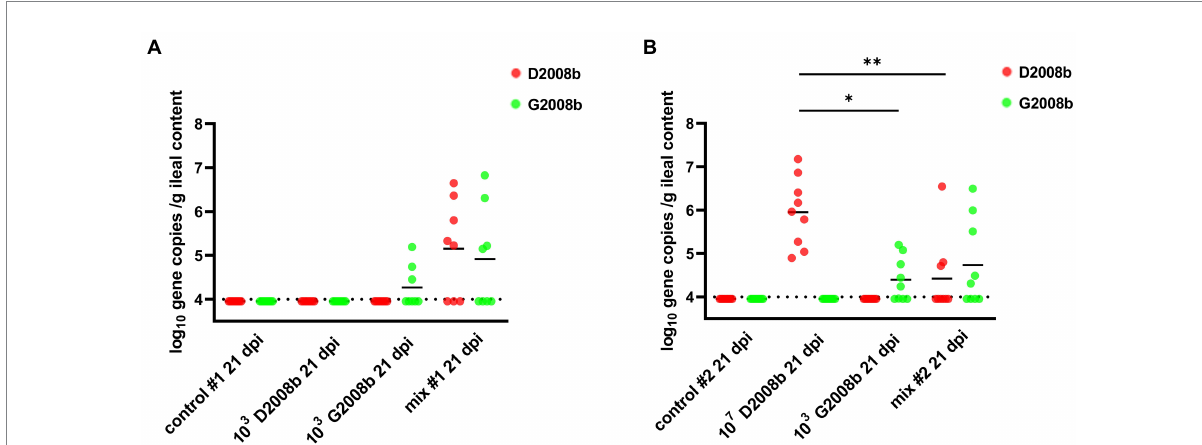
FIGURE 4 Amounts of Campylobacter jejuni strains in ileal content (log 10 gene copies/g of ileal content) from birds at 7 and 21 dpi for room 1 (A) and room 2 (B) . Red and green dots correspond to the amount of D2008b and G2008b, respectively, for individual birds. Horizontal bars represent median values, and horizontal dotted lines denote the threshold (4 log 10 CFU/g of ileal content). Statistical analyzes were conducted using a Kruskal-Wallis test followed by Dunn’s post-hoc tests with Bonferroni adjustments to compare median values between colonized groups according to the time point and room. * and ** indicate p <0.05 and p <0.01 respectively.